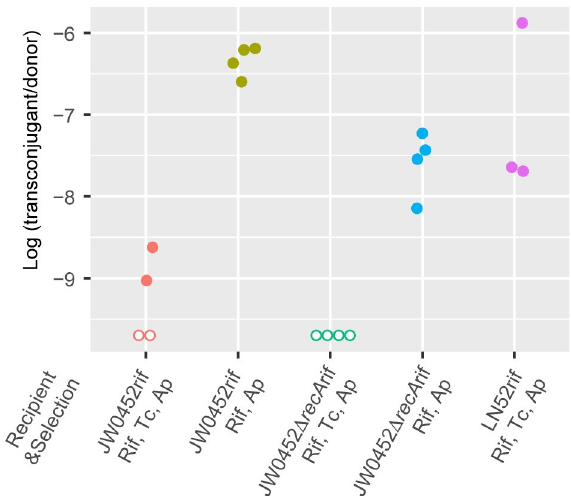
Fig 4. Resistance gene transfer from V . alfacsensis . Transfer frequency (Y-axis) is the log 10 -transformed value of the transconjugant colony-forming units (CFU) divided by the donor CFU. Four replicate mating experiments were performed. No transconjugants were detected in any of the four replicate experiments using JW0452 Δ recA rif with Tc Ap selection or in the two replicate experiments using JW0452rif with Tc Ap selection (indicated by open circles placed at the bottom). In one experiment on LN52rif, the donor CFU was not evaluated, but the transconjugant CFU was obtained at a comparable frequency to that observed in the other three replicate experiments. The detection limit of this experiment was around 1.02 × 10 − 9 per